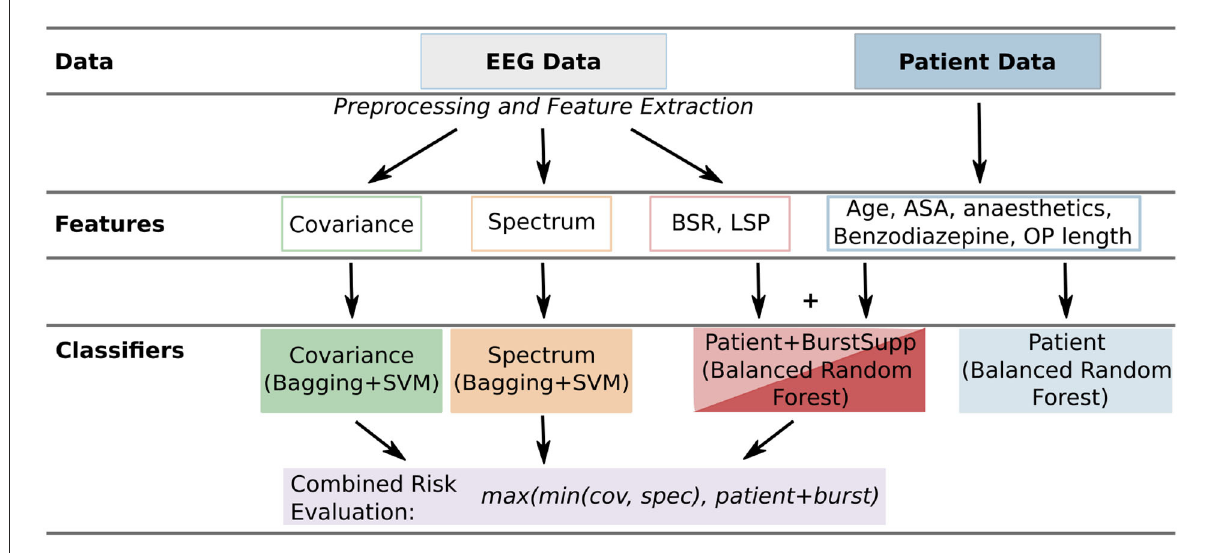
FIGURE1 Overview of the used features and classifiers. For each patient, there are two general types of data: the EEG data and the patient data. From the EEG data, three types of features [time-dependent: covariance and spectrum, numerical: burst suppression ratio (BSR), and longest suppression phase (LSP)] are extracted (Section 2.1). From the patient data, the data easily available in the operating room is used. These features are classified by different classifiers (covariance, spectrum, patient+burstsupp, combined risk evaluation, and patient data classifier; Section 2.2) and then evaluated and compared (Section